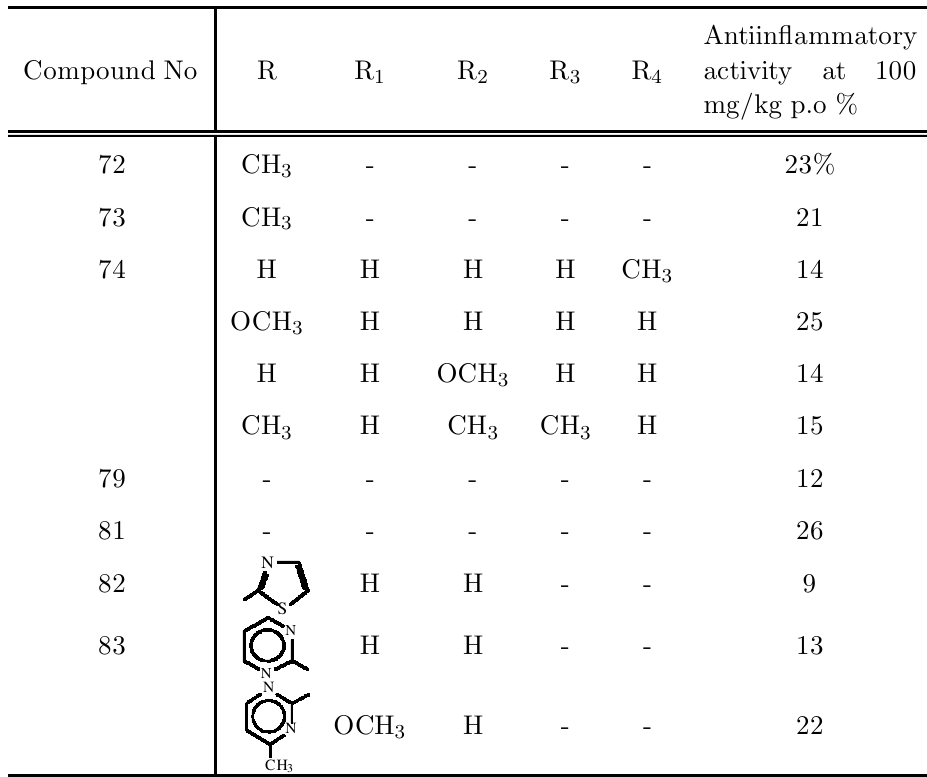
Table 2 Antiin®ammatory activity of acridine